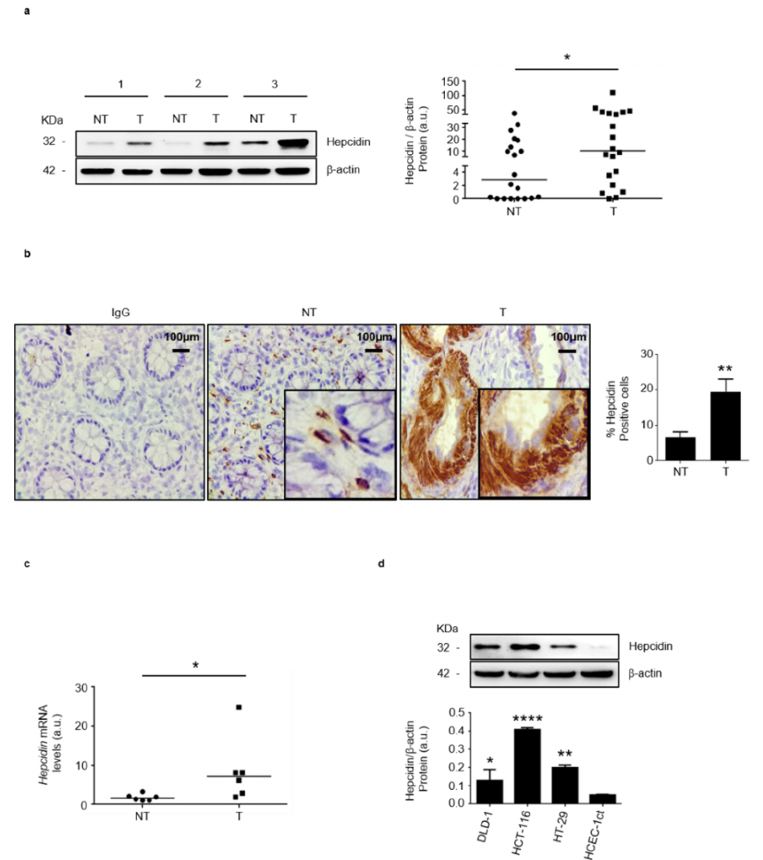
Figure 1. Hepcidin expression is increased in CRC. ( a ). Hepcidin protein expression was evaluated in paired tissue samples taken from the tumor area (T) and the adjacent, non-tumor area (NT) of CRC patients by Western blotting. β -actin was used as a loading control. Left panel: representative Western blots of hepcidin and β -actin in 3 different patients; right panel shows the quantitative analysis of hepcidin/ β -actin protein ratio, as measured by densitometry scanning of Western blots. Each point in the graph indicates the value of hepcidin/ β -actin in a single patient. Values are expressed in arbitrary units (a.u.); NT versus T, * p < 0.05; n = 20). ( b ). Representative images of immunohistochemistry of colon sections of paired tissue samples taken from the T and NT areas of CRC patients. Staining with a control isotype IgG is also shown. Scale bars, 100 μ m. Inset shows staining at higher magnification. Right inset: the percentages (%) of hepcidin-positive cells in sections taken from the NT and T areas of 6 CRC patients. Data are expressed as mean ± SD (** p < 0.01) ( c ). Hepcidin RNA expression was evaluated in paired tissue samples taken from the T and NT areas of CRC patients by RT-PCR, and values were normalized to β -actin. Each point in the graph represents the value of hepcidin mRNA in a single patient (* p < 0.05; n = 6) ( d ). Hepcidin protein expression in CRC cell lines (DLD-1; HCT-116; HT-29) and HCEC-1ct cells evaluated by Western blotting. Representative Western blots and quantitative analysis of hepcidin/ β -actin protein ratio, as measured by densitometry scanning of Western blots are shown. In the lower panel, values are expressed in arbitrary units (a.u.) and indicate mean ± SD of all experiments; DLD-1 versus HCEC-1ct, * p < 0.05; HCT-116 versus HCEC-1ct, **** p < 0.0001; HT-29 versus HCEC-1ct, ** p < 0.01; n = 3).